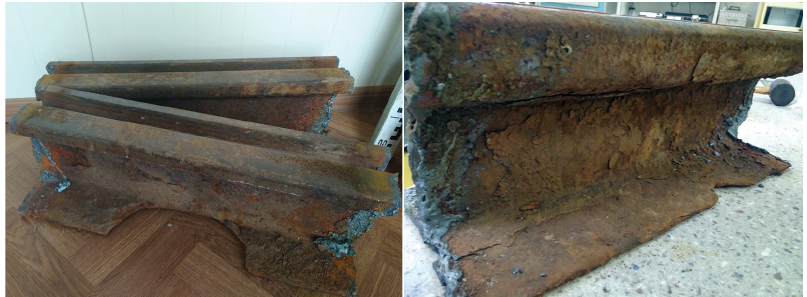
Figure 2. Rail degradation noticed at urban